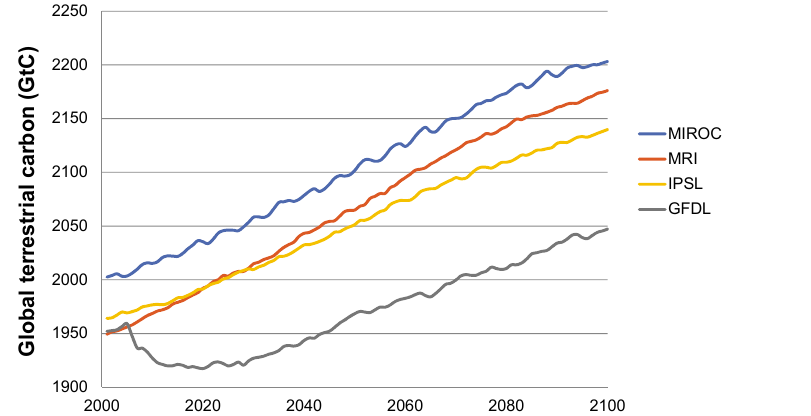
Figure A3. Global terrestrial biosphere carbon (GtC) simulated with climate forcing fields from four GCMs – MIROC (Watanabe et al., 2010), MRI (Yukimoto et al., 2012), IPSL (Dufresne et al., 2013) and GFDL (Donner et al., 2011) for medium LULCC (SSP2m) and RCP4.5-driven climate change. Uncertainties due to different process representations in the four GCMs arrive at differences across the GCMs in 2100 which are similar to the total simulated change for one GCM (e.g. difference MIROC-GFDL is around 150GtC in 2100, while total simulated change of GFDL is around 100GtC or 200 for MIROC). The initial dip in GFDL terrestrial carbon is mainly caused by Amazon forest